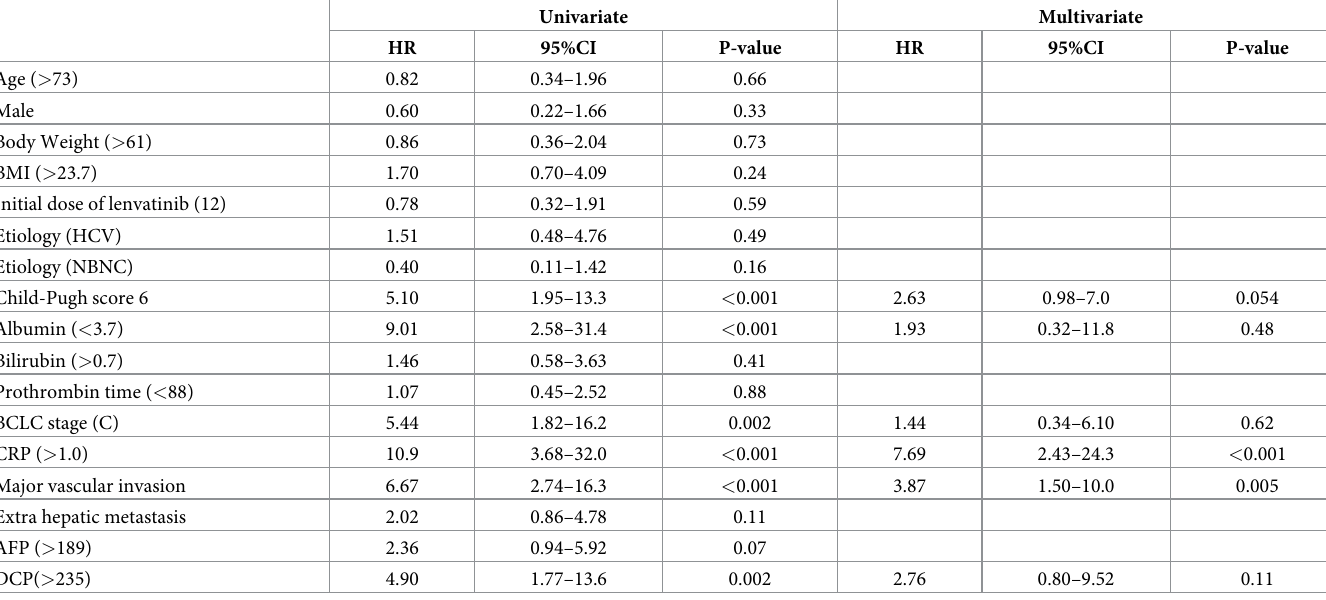
Table 2. Univariate and multivariate analysis to determine the factors associated with overall survival.